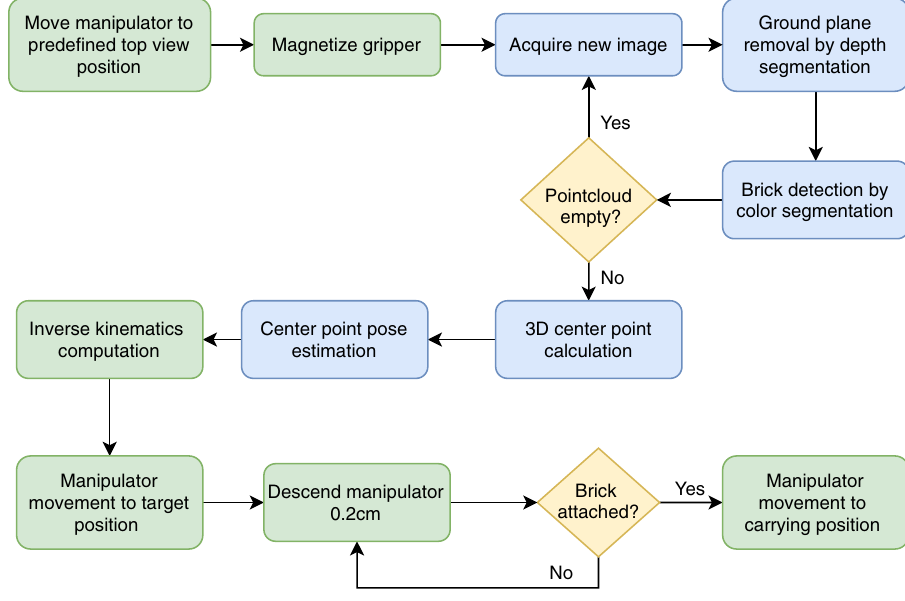
Fig. 11 Flowchart describing the brick detection and picking